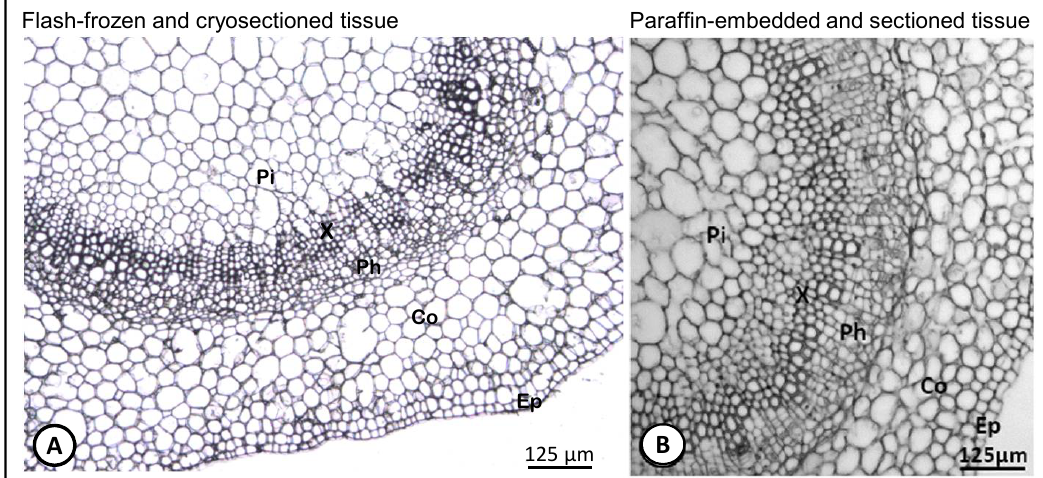
Figure 3. Cross sections of the stem nodal segments of olive microcuttings at the site of adventitious root formation showing a vascular bundle (Pi, pith; Co, cortex; Ep, epidermis; Ph, phloem; X, xylem). ( A ) Tissue cryosection prepared as described in the material and methods of the present work. ( B ) paraffin-embedded tissue prepared as described in Macedo et al.